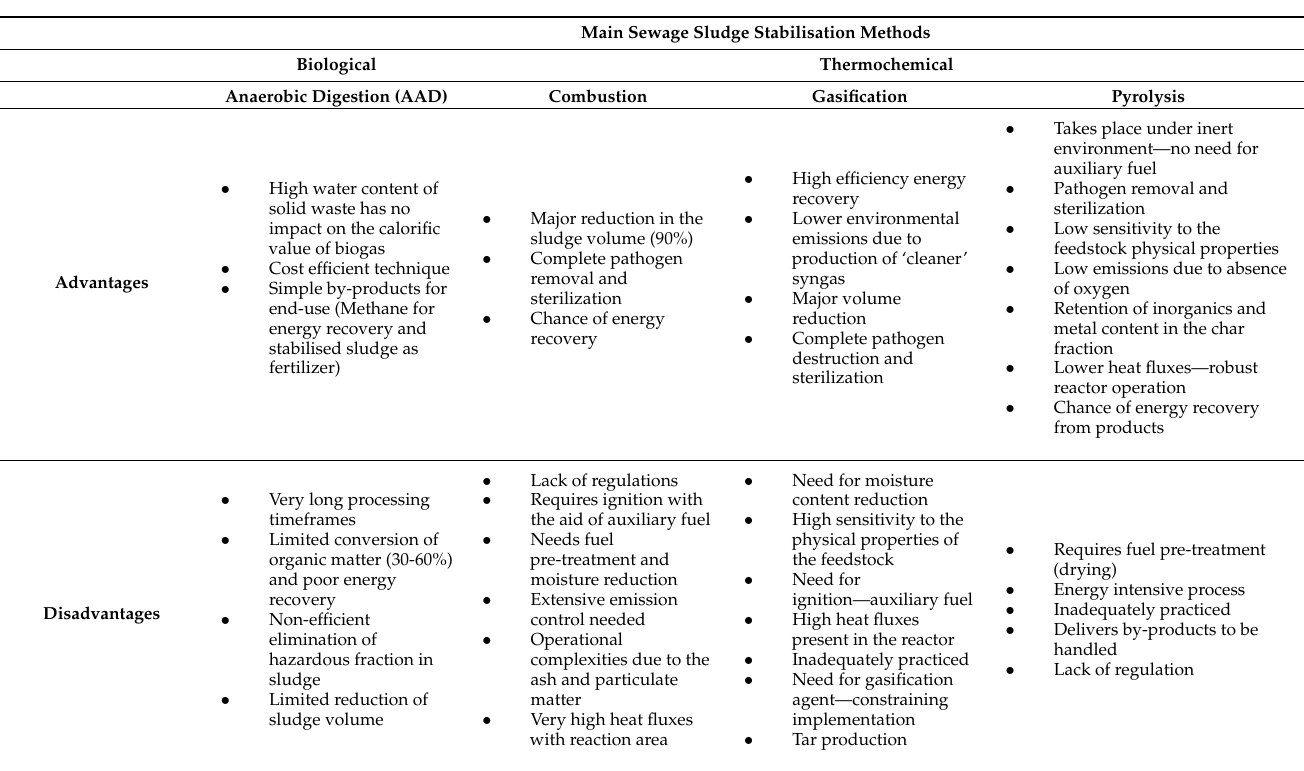
Table 2. Pros/cons of sewage waste stabilisation